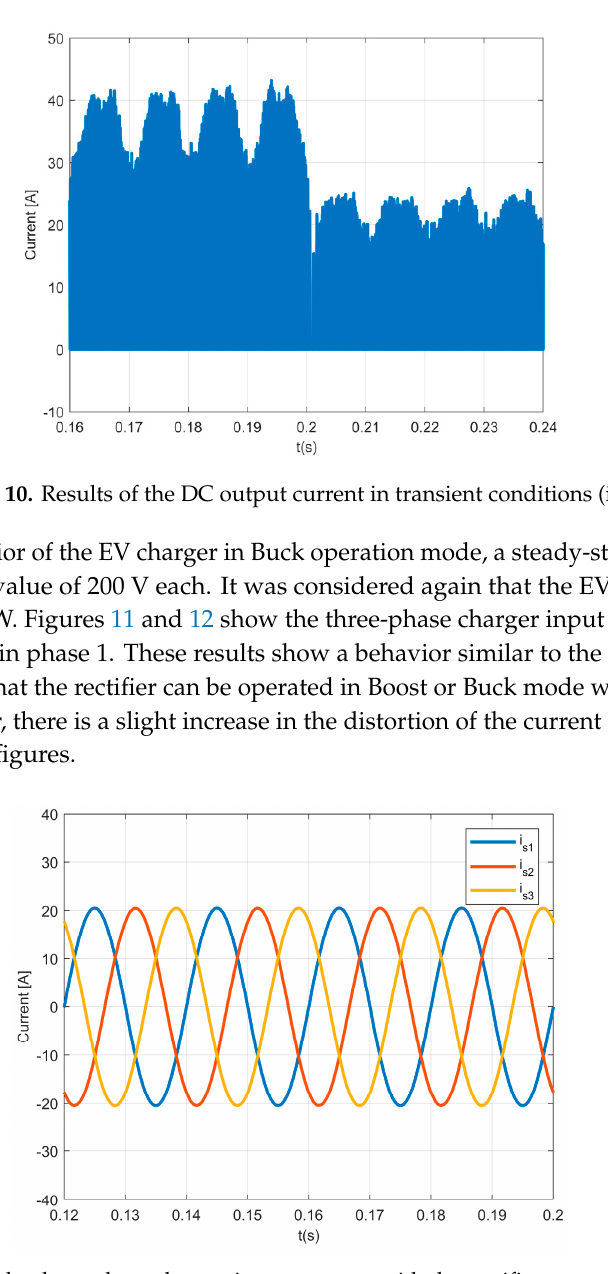
Figure 11. Results of the three-phase charger input currents with the rectifier operating in Buck mode.